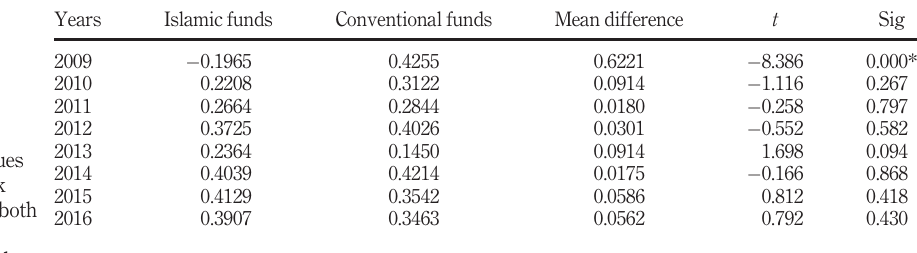
Table III. Yearly mean values of systematic risk (CAPM beta) for both